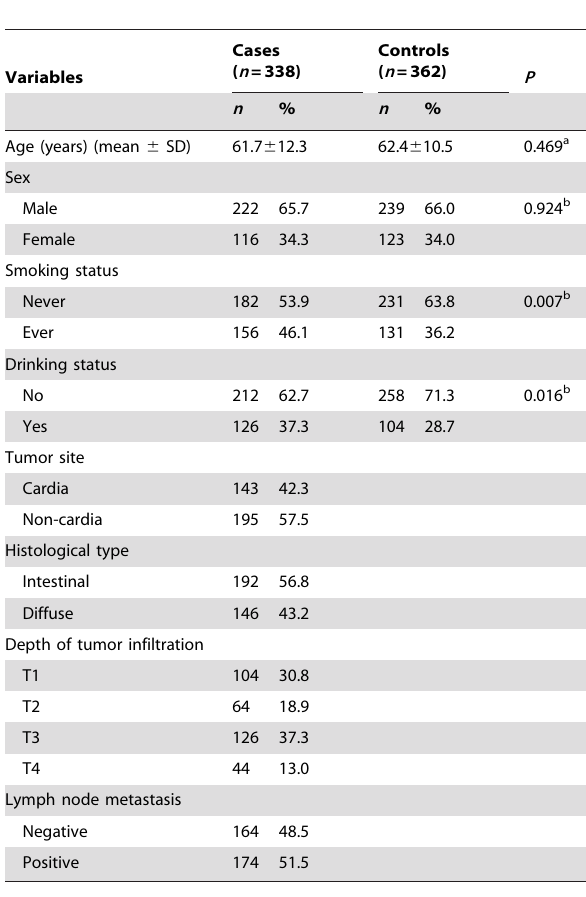
Table 1. Distribution of selected variables between the gastric cancer cases and control subjects.